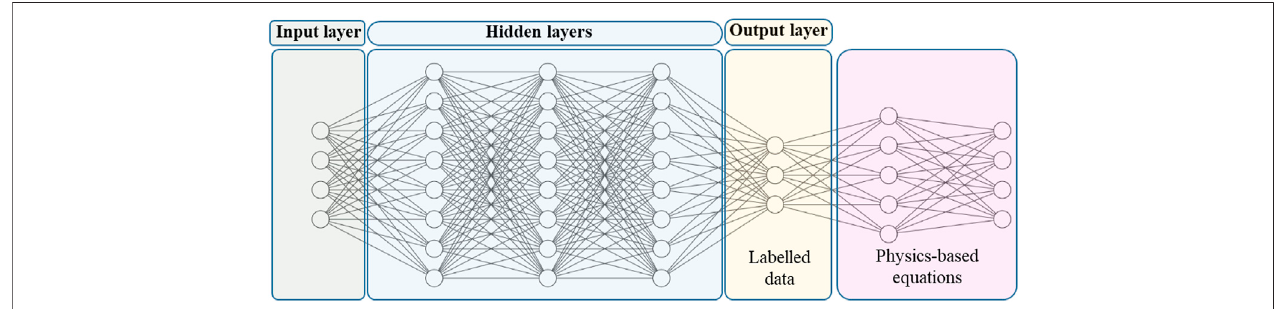
FIGURE 6 | Architecture of a typical PIDL model.